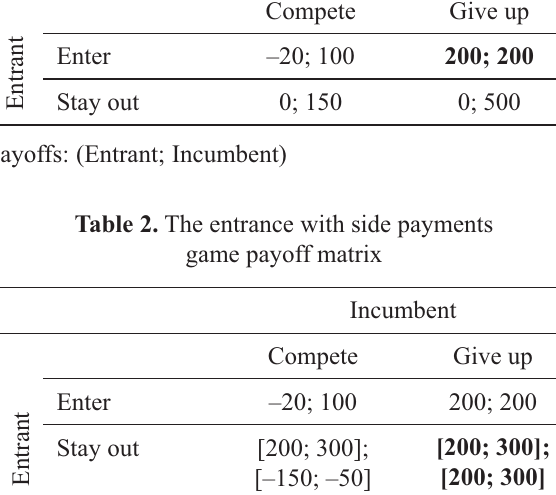
Table 3. The mixed strategies game payoff matrix